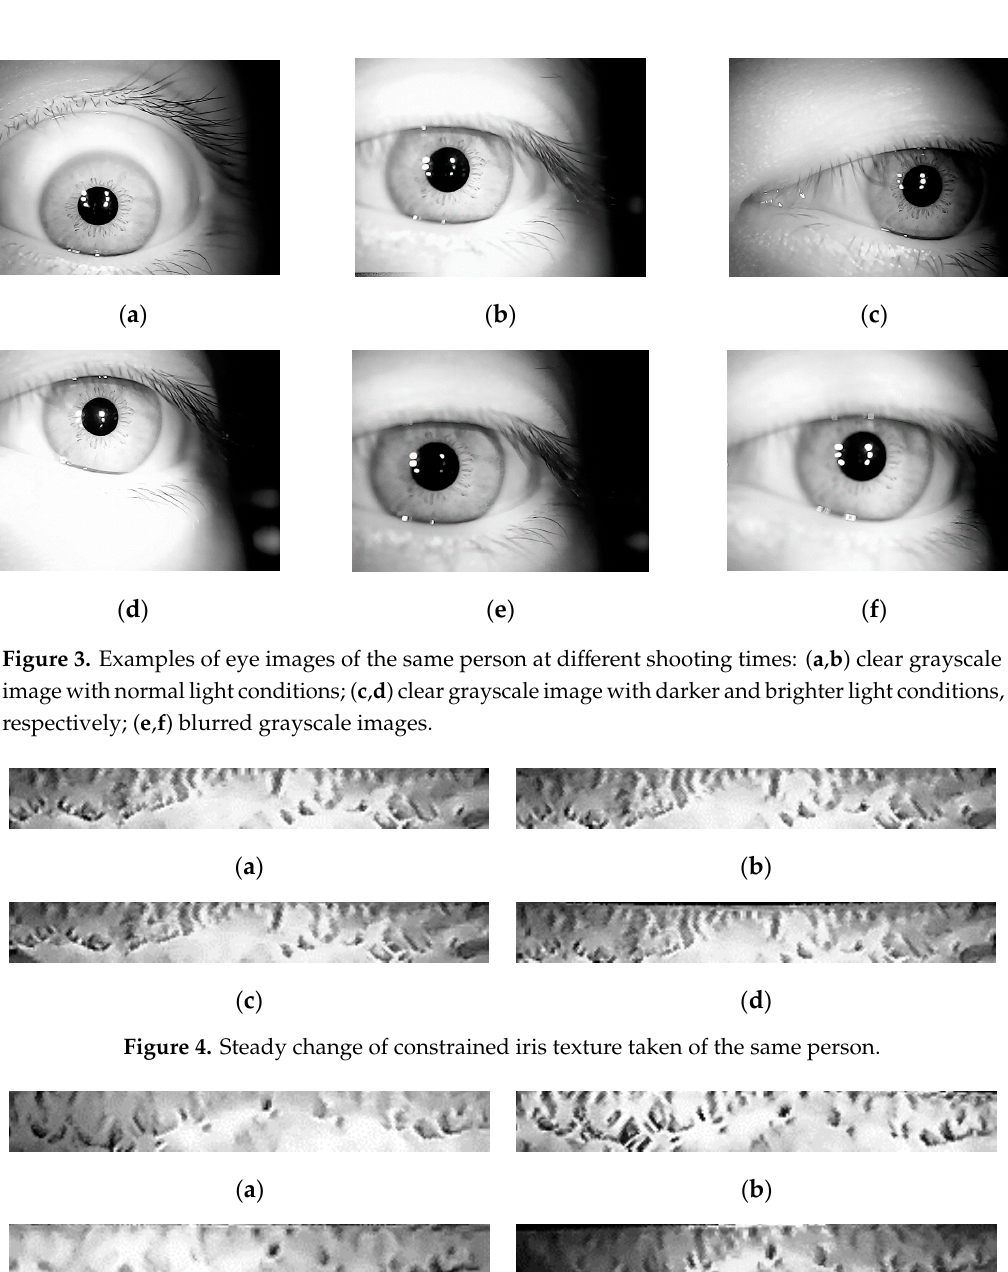
Figure 4. Steady change of constrained iris texture taken of the same person.